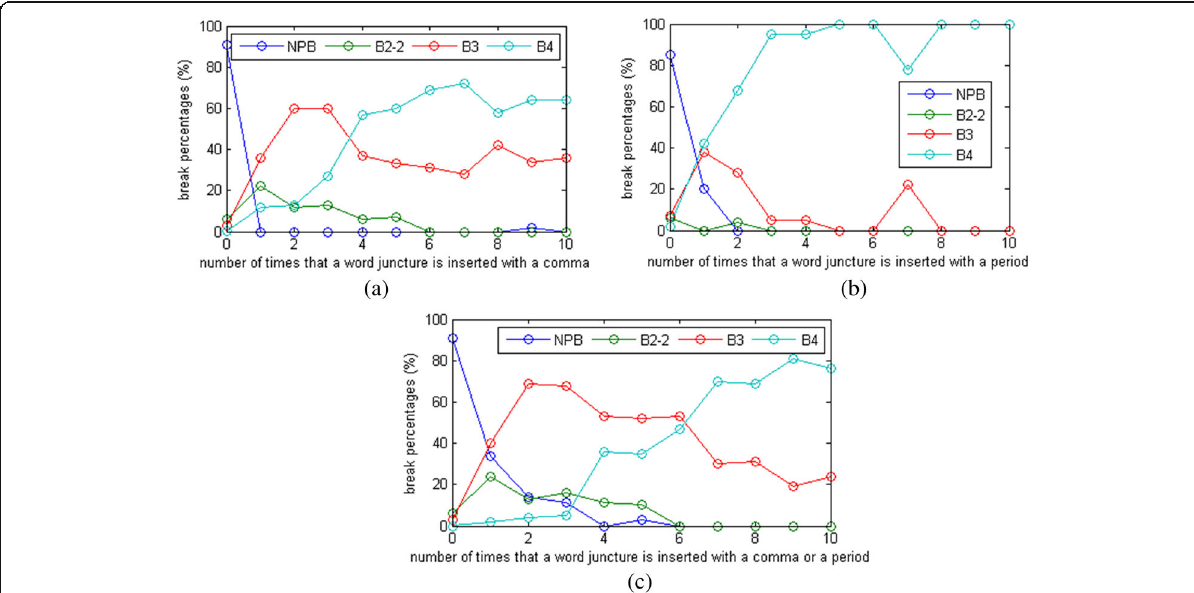
Fig. 3 Average percentage of prosodic break types dependent on the number of times that a word juncture was inserted with a comma ( a ), period ( b ), and comma or period ( c